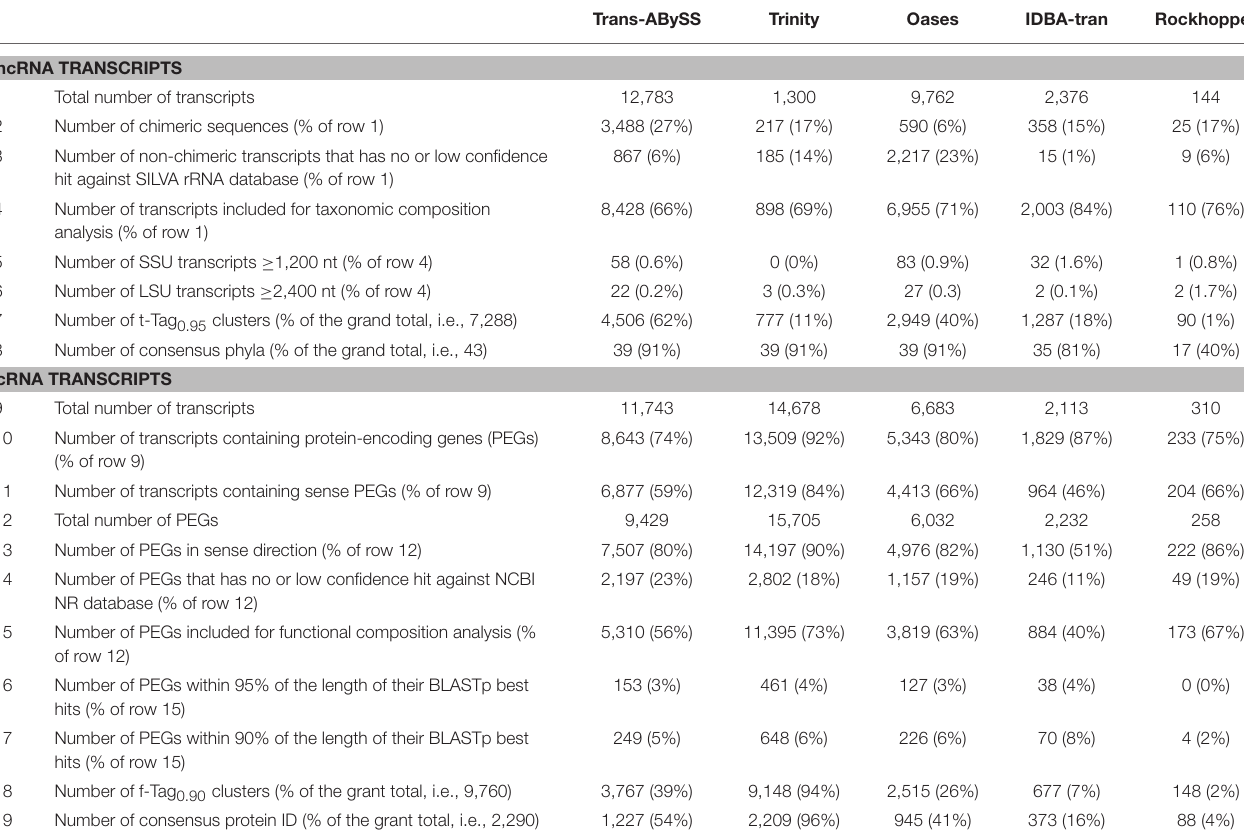
TABLE 2 | Summary of de novo metatranscriptomic assemblies of non-coding (nc) and coding (c) RNA-Seq reads based on homology